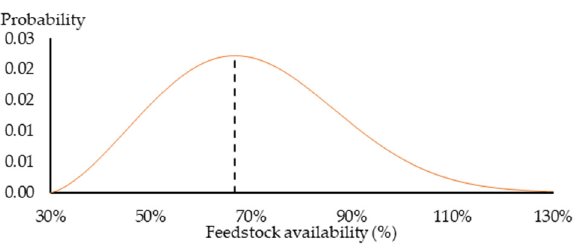
Figure 13. Feedstock availability.